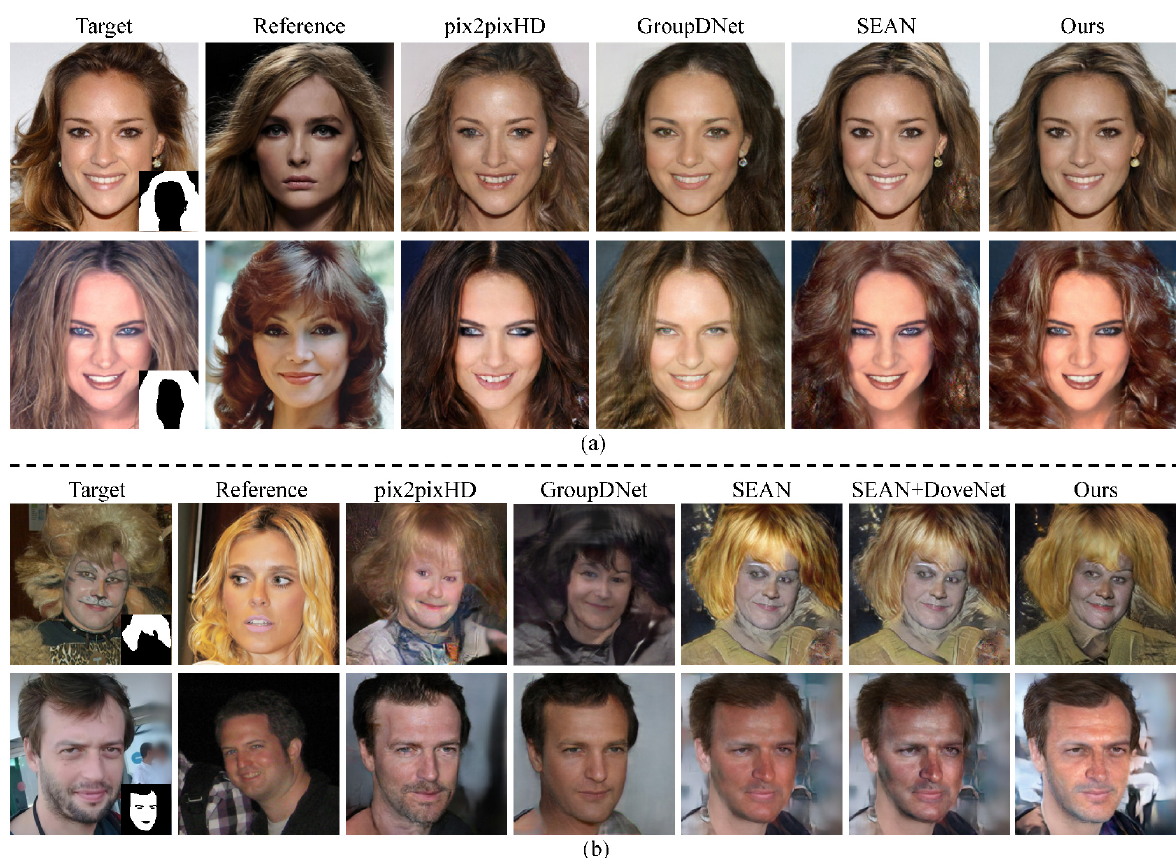
Fig. 7 Regional style transfer results (segmentation mask shown as inset). (a) Target and reference images from the same dataset. (b) Cross dataset transfer. Our model generates more harmonious results than DoveNet [17] performed on the outputs of SEAN